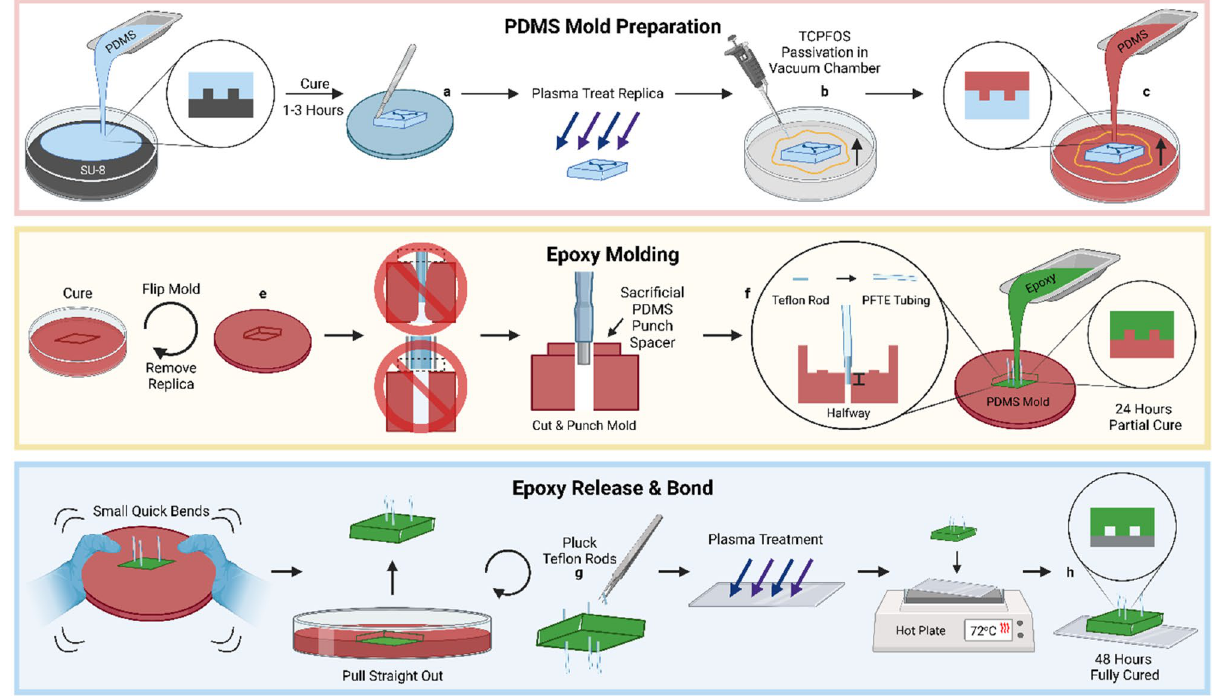
Figure 1. Overall procedure to fabricate epoxy-based microfluidic device.